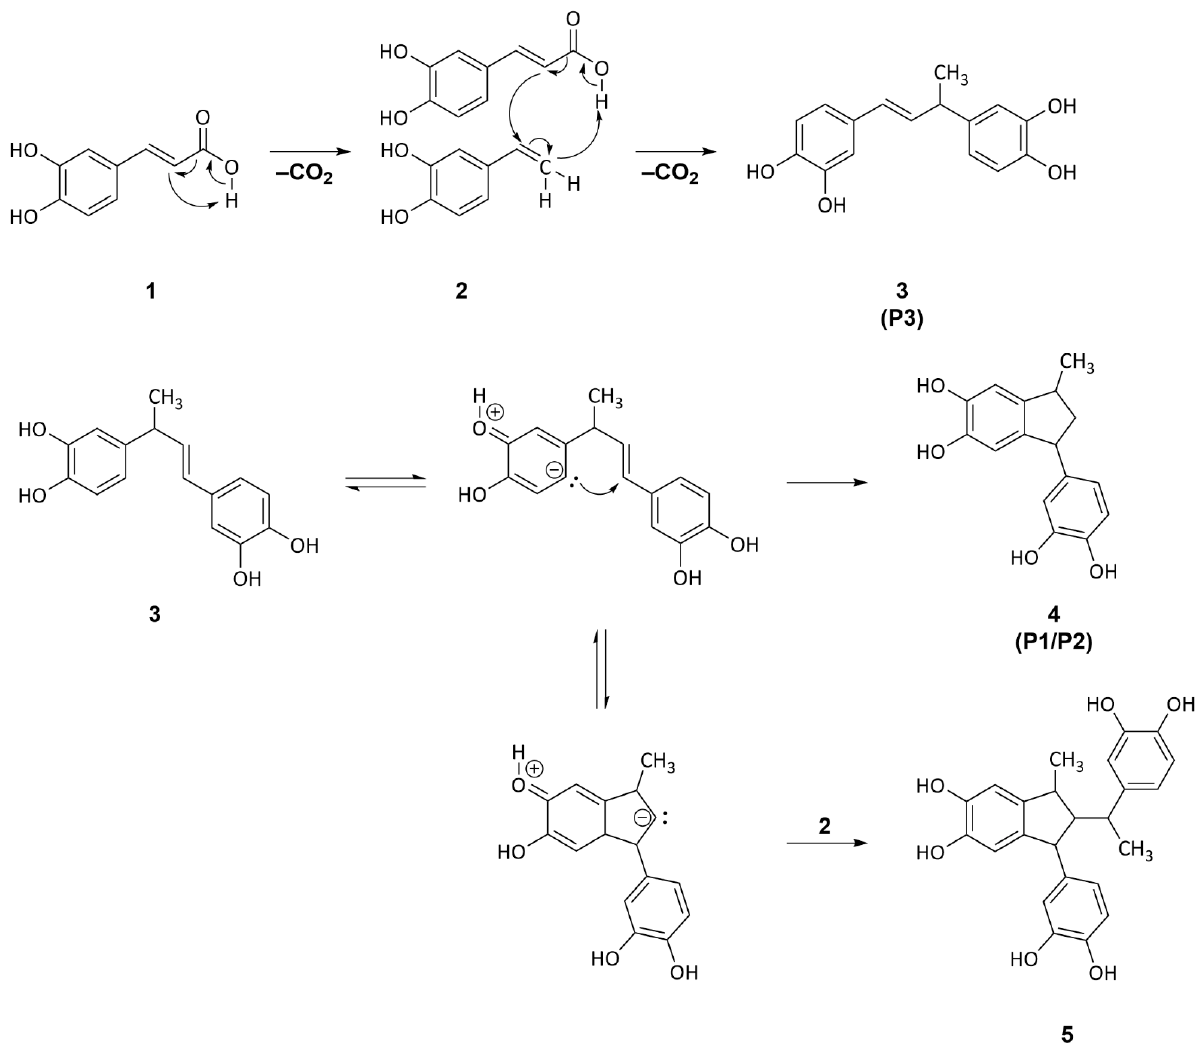
Figure 4. Decarboxylation of caffeic acid 1 and the subsequent oligomerization of 4-vinylcatechol 2